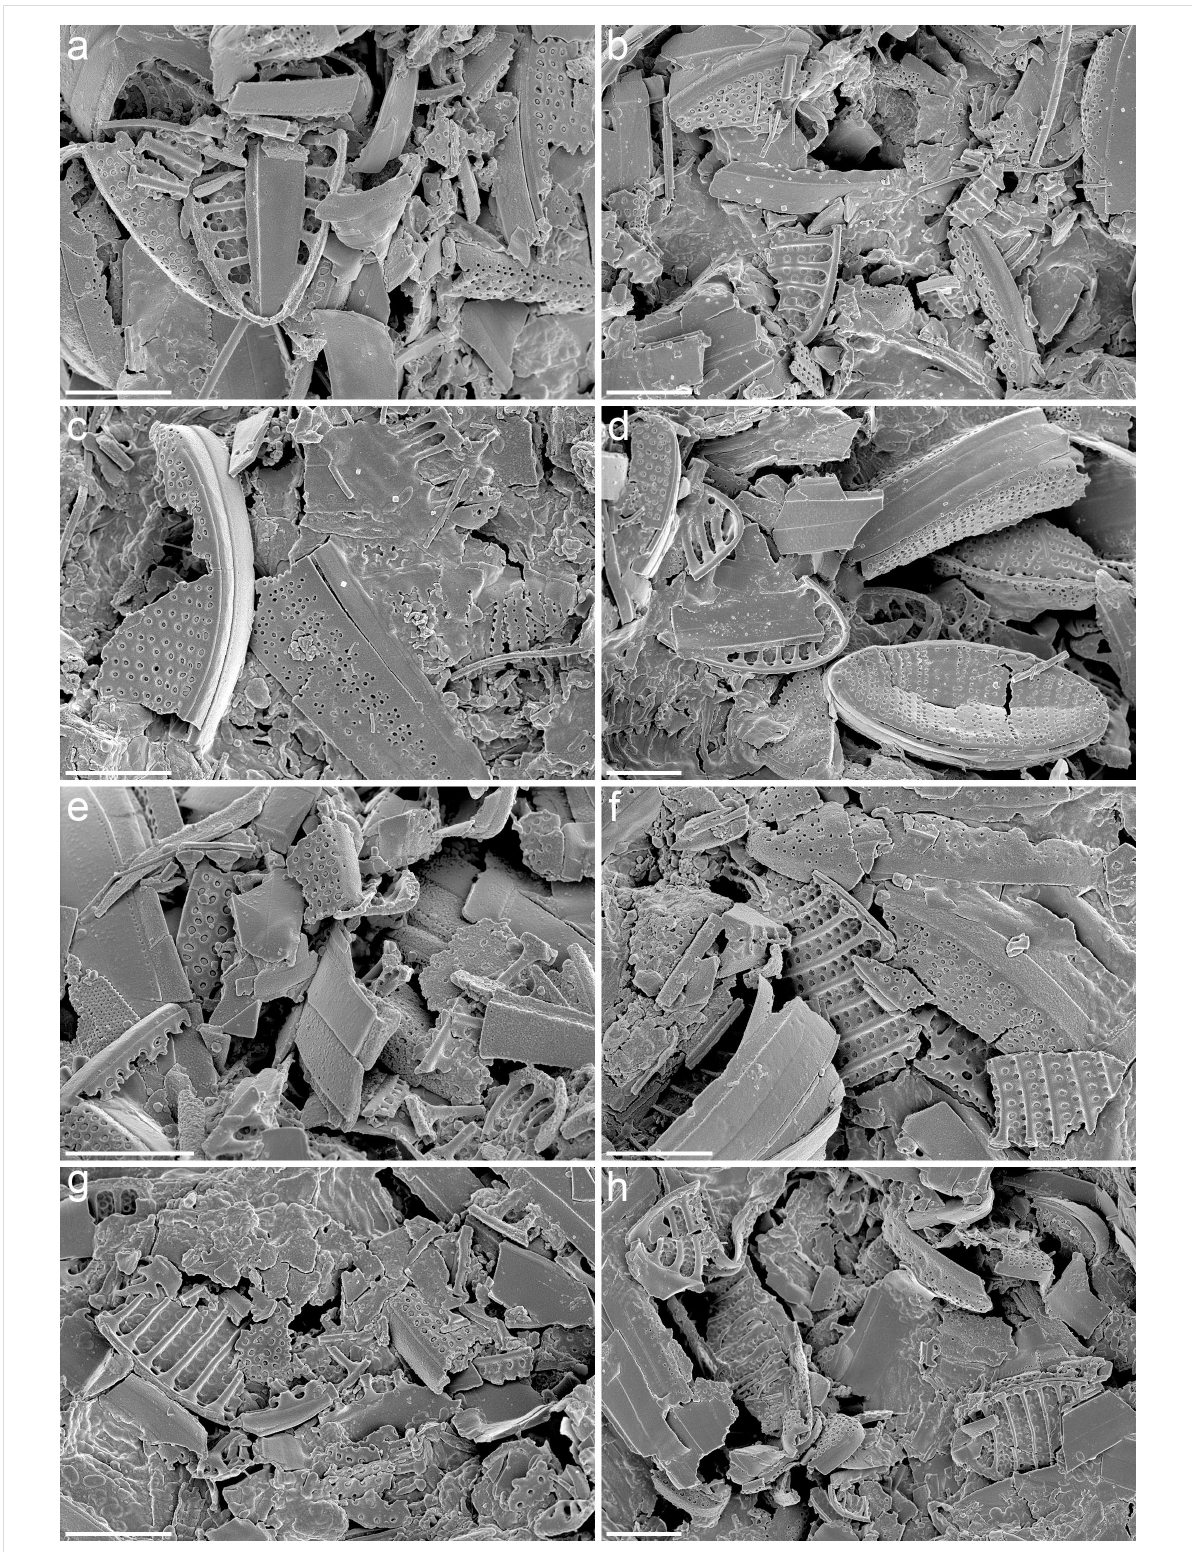
Figure 8: Faecal pellets from feeding experiments with the diatom species Fragilariopsis kerguelensis and juveniles (copepodite stage V) of the Antarctic copepod species Calanus propinquus . (a–h) Scanning electron micrographs showing pieces of F. kerguelensis frustules present in the faecal pellets. Scale bars = 5